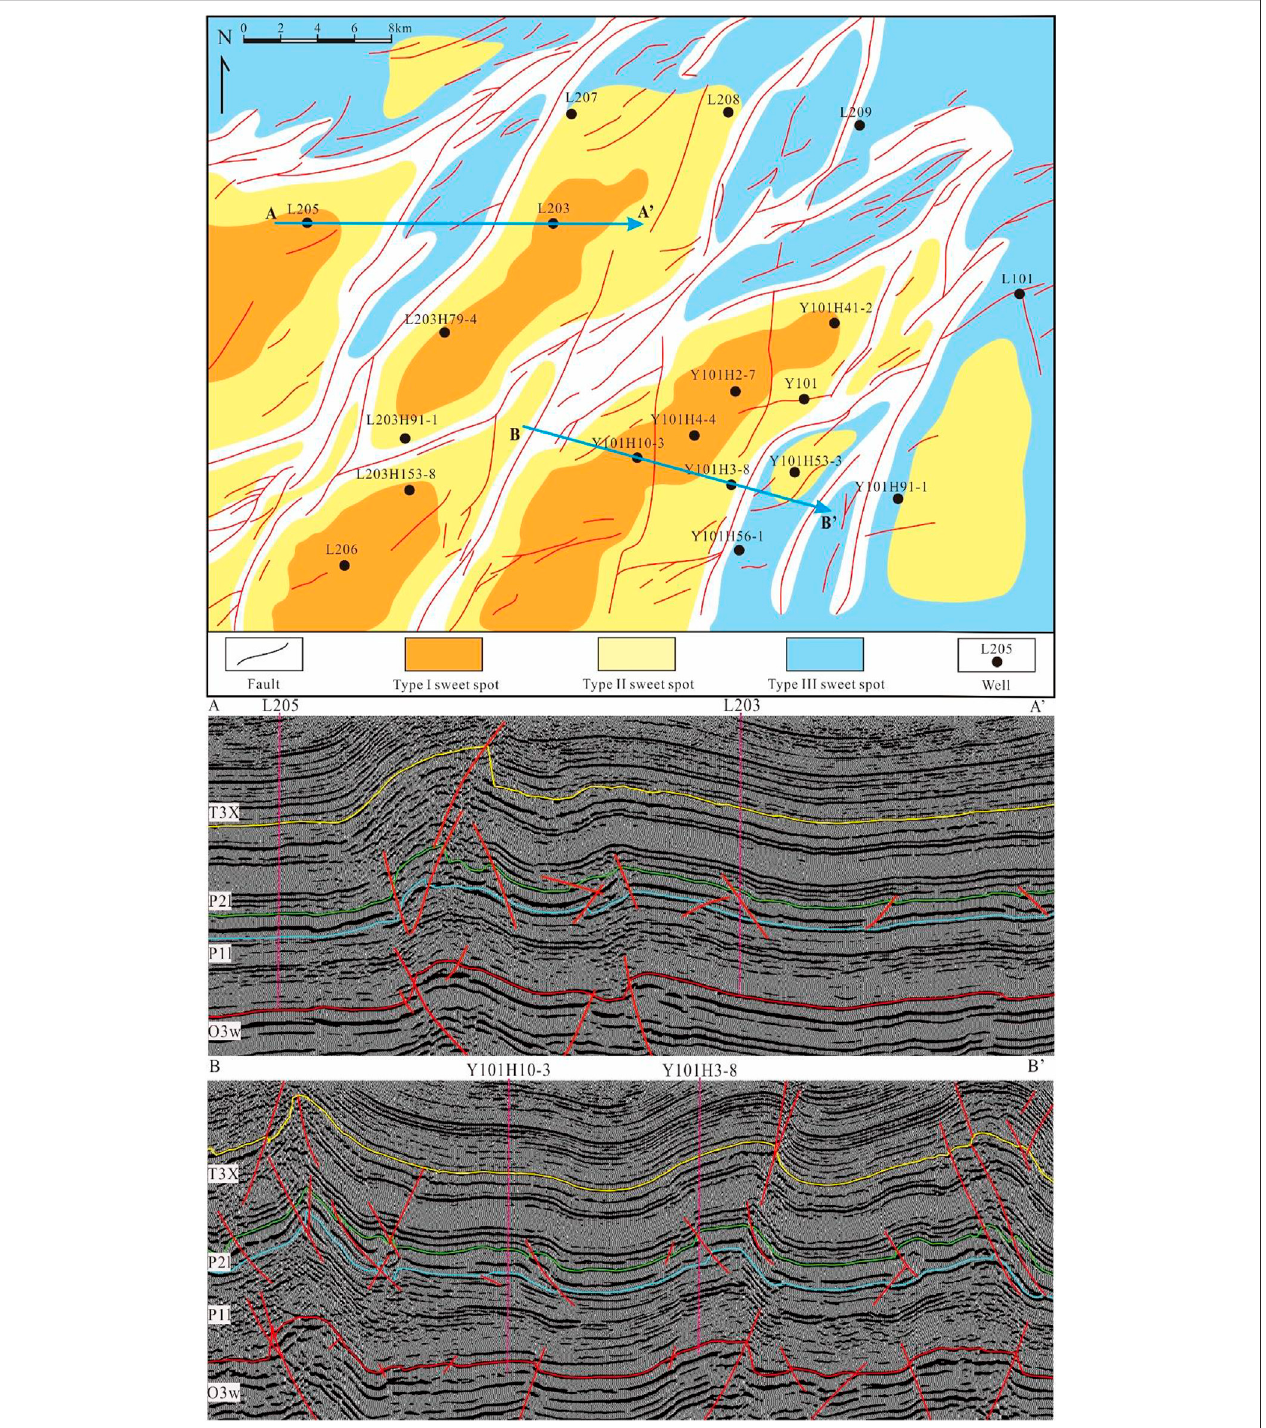
FIGURE 13 | Favourable area for shale gas preservation in the Luzhou area.